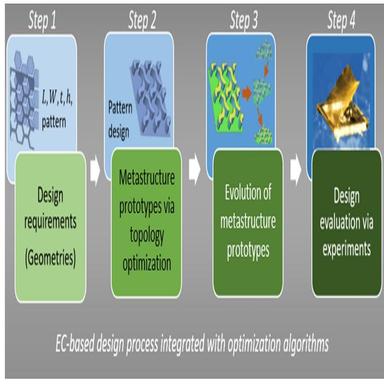
Vision for the EC-based design process integrated with optimization algorithms to artificially evolve metastructures with corrugation.